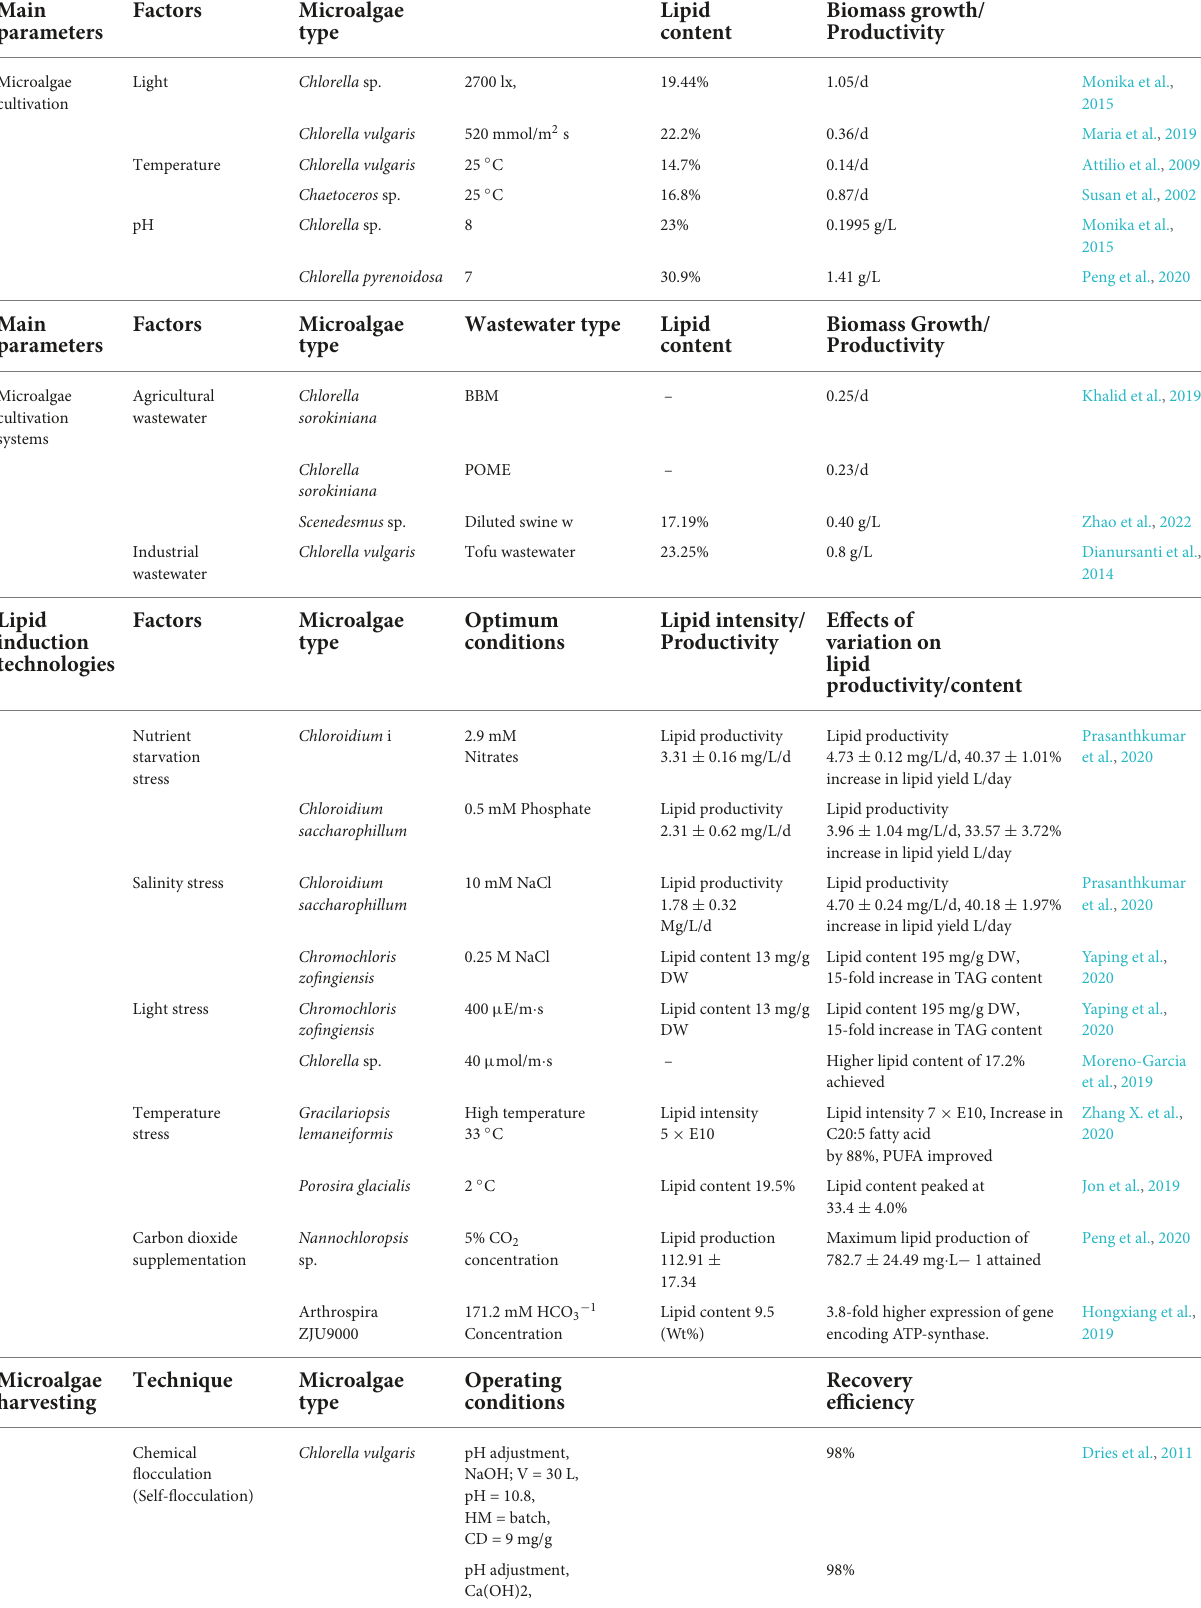
TABLE 2 Comparison of the mainly parameters and technologies for biodiesel